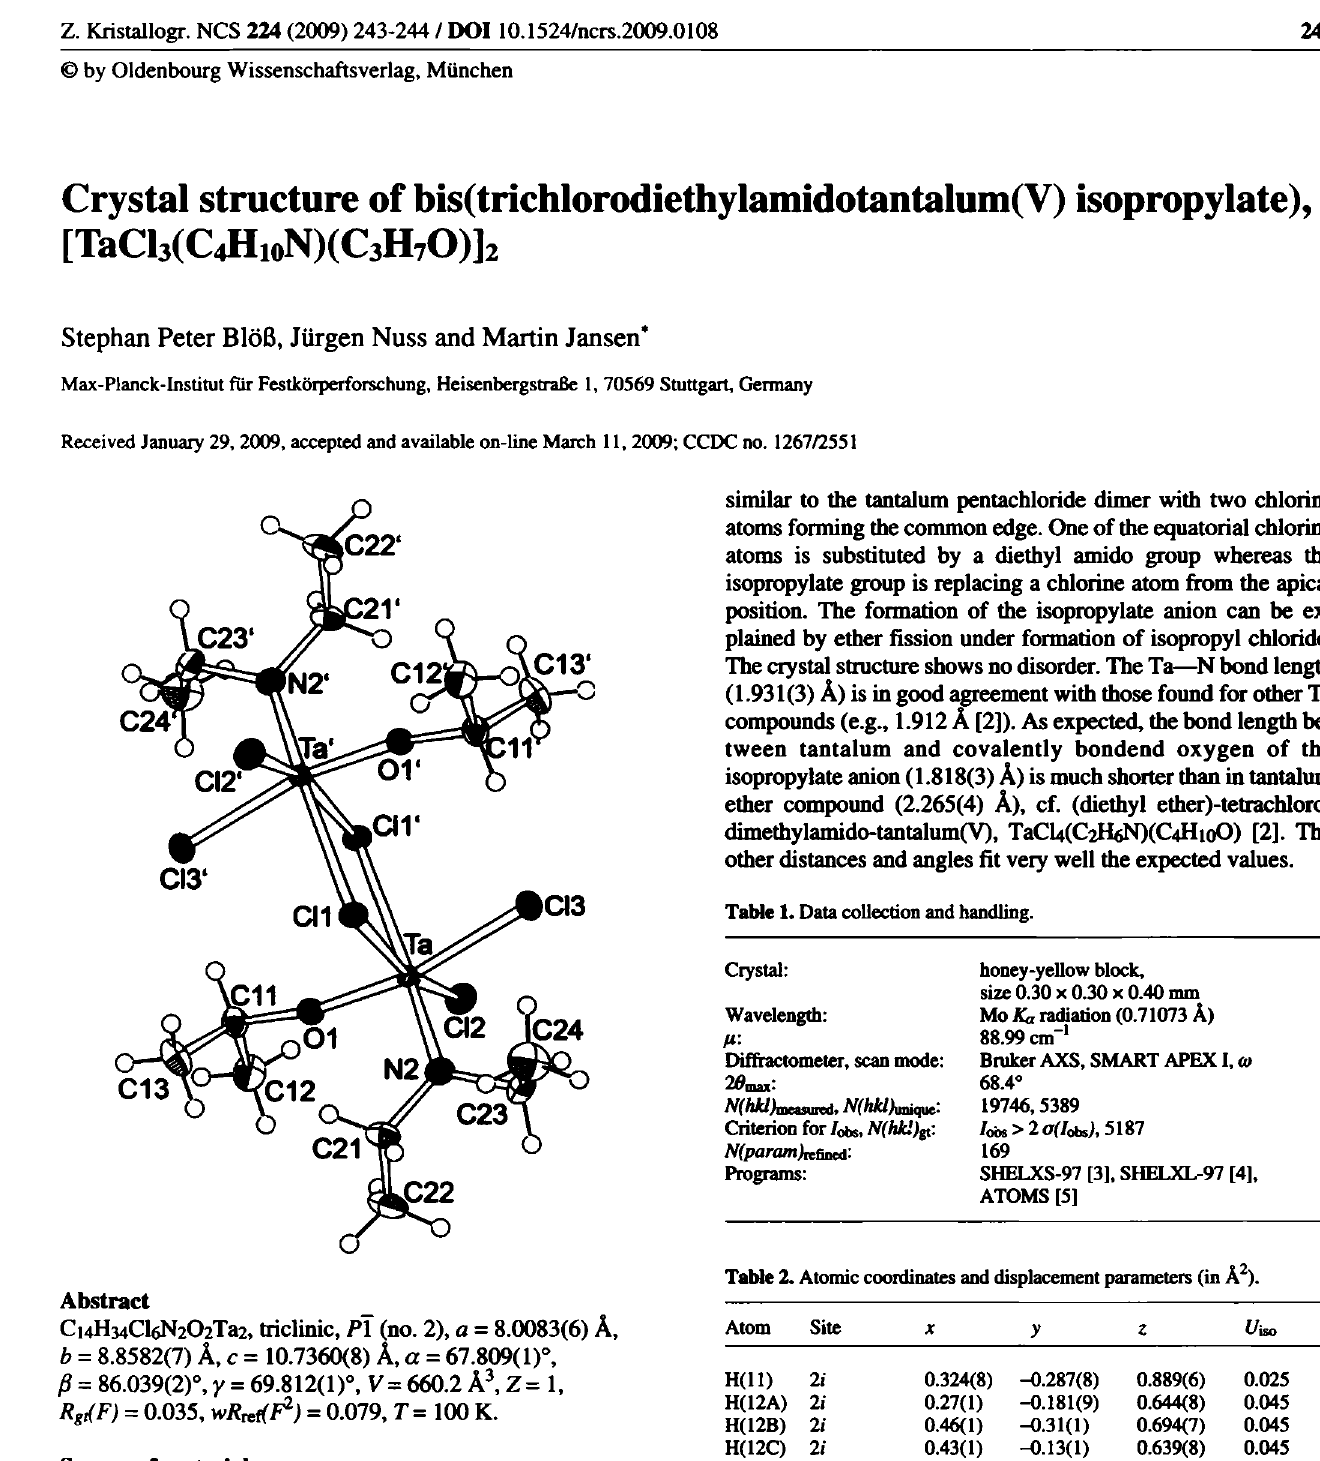
Table 2. Atomic coordinates and displacement parameters (in Â 2